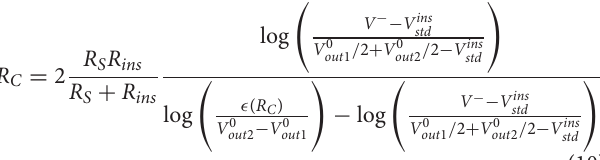
With 1 t transit the initial delay such